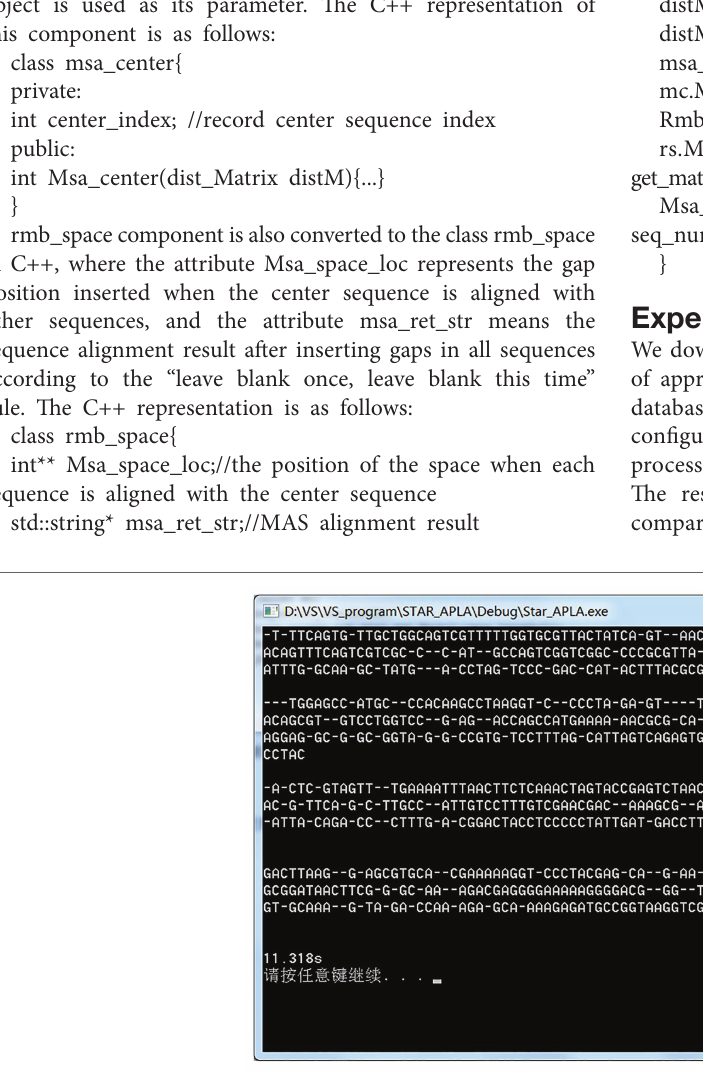
FIGURE 2 | Snapshot of the alignment